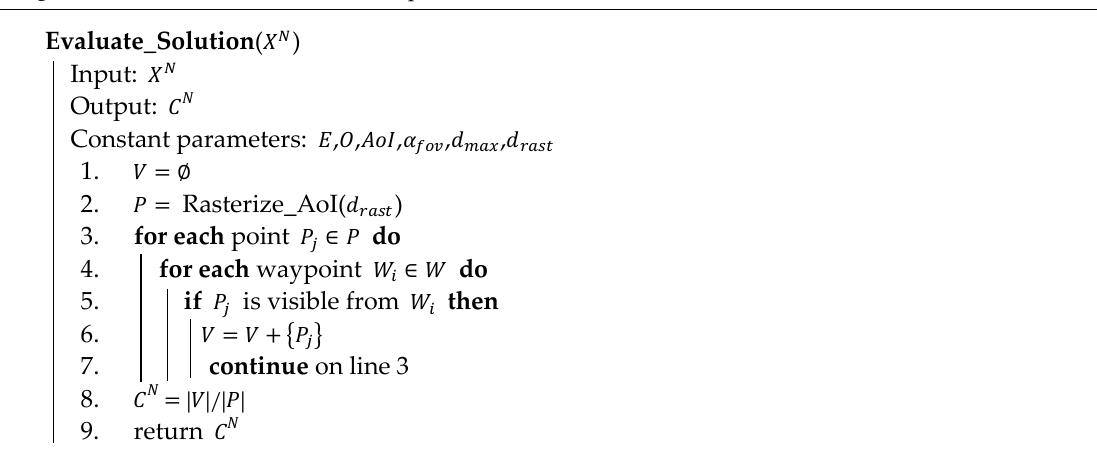
Algorithm 1 Evaluation of a solution in pseudocode